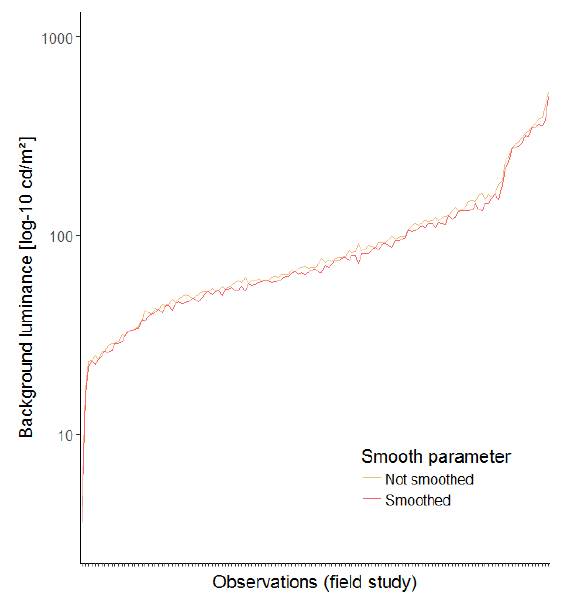
Figure 38. Comparison of the background luminance while varying the smooth parameter with the t4 method (task area method with a factor 4), for all glare evaluations of the field study.